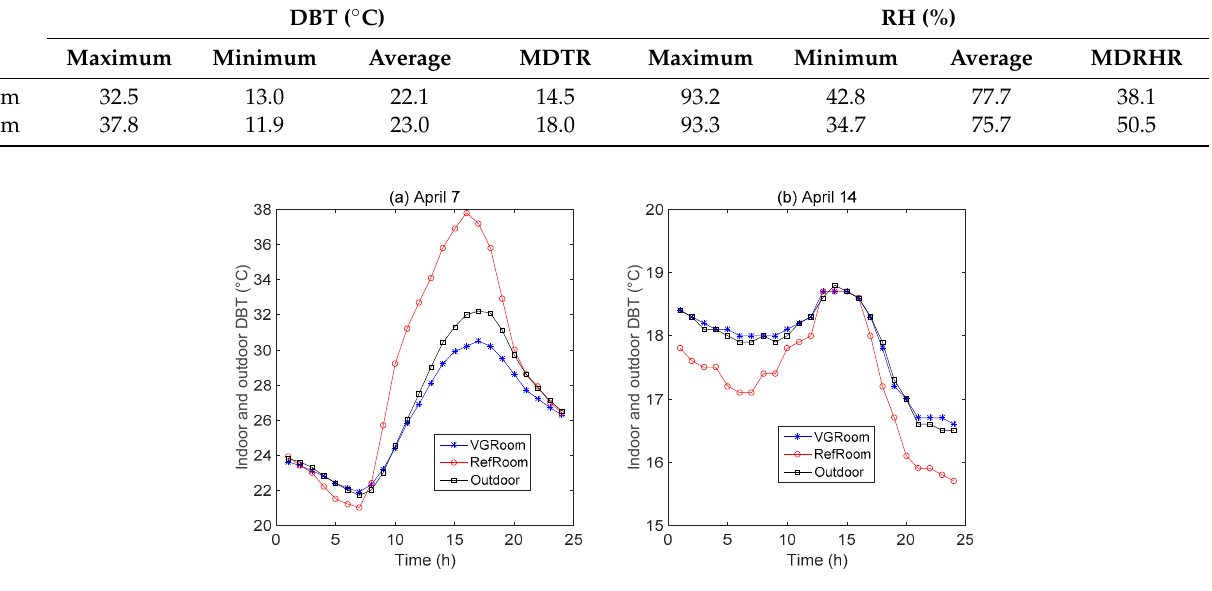
Figure 6. Indoor DBT values for the experimental rooms and the outdoor DBT. ( a ) The indoor DBT values on April 7. ( b ) The indoor and outdoor DBT variations on 14 April